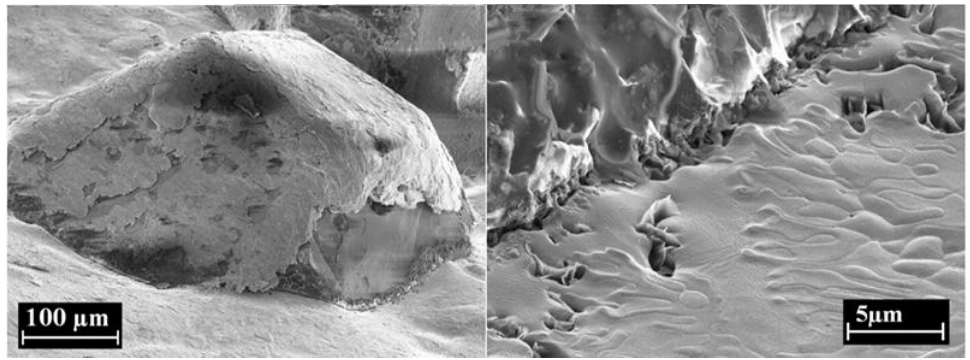
Figure 6. SEM-images of the interface, showing wetting behavior of the diamonds [71], Elsevier, 2016.